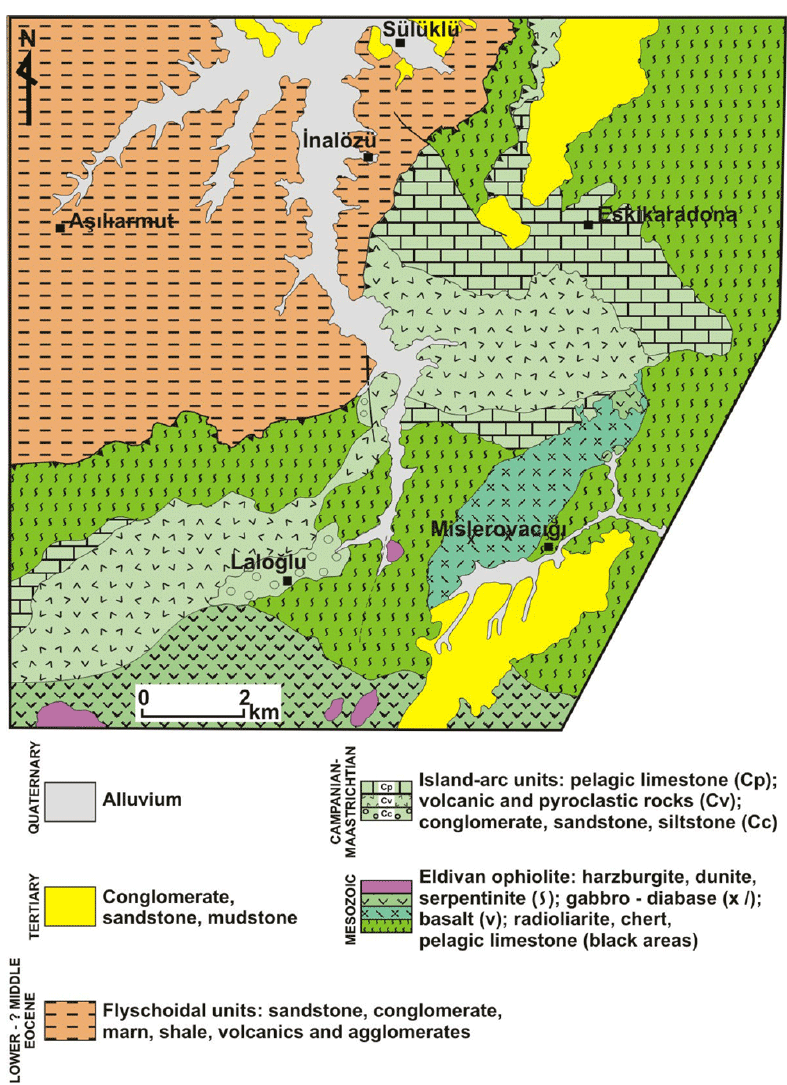
Fig. 7. Geological map of the Laloglu (Çorum) area, showing the Neotethyan Eldivan ophiolite and the island arc rock units. Table 3. Whole-rock K / Ar age data from metamorphic rock blocks in the Ankara Mélange, Turkey. Sample